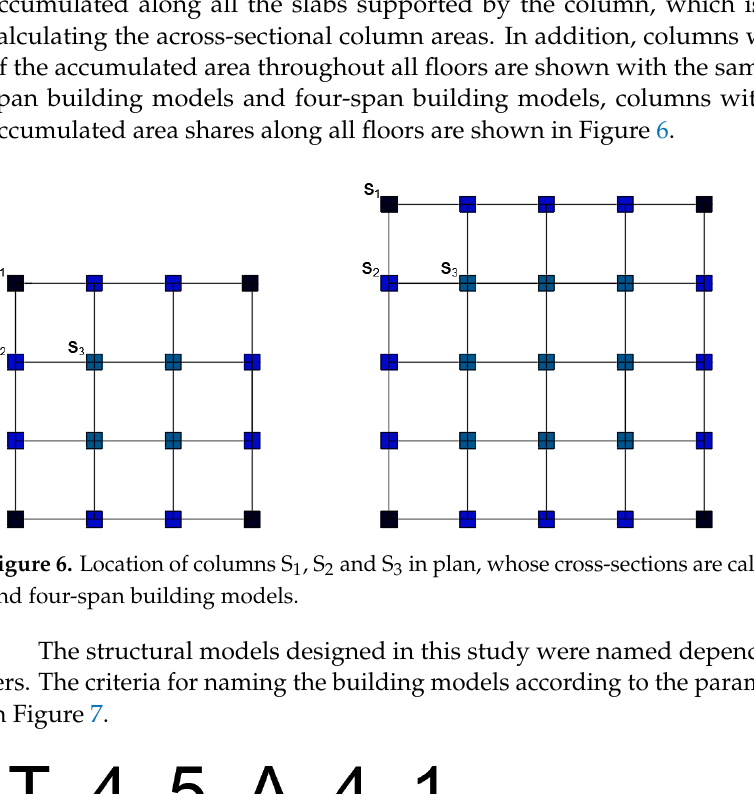
Table 4. Column dimensions and reinforcements details for each model.